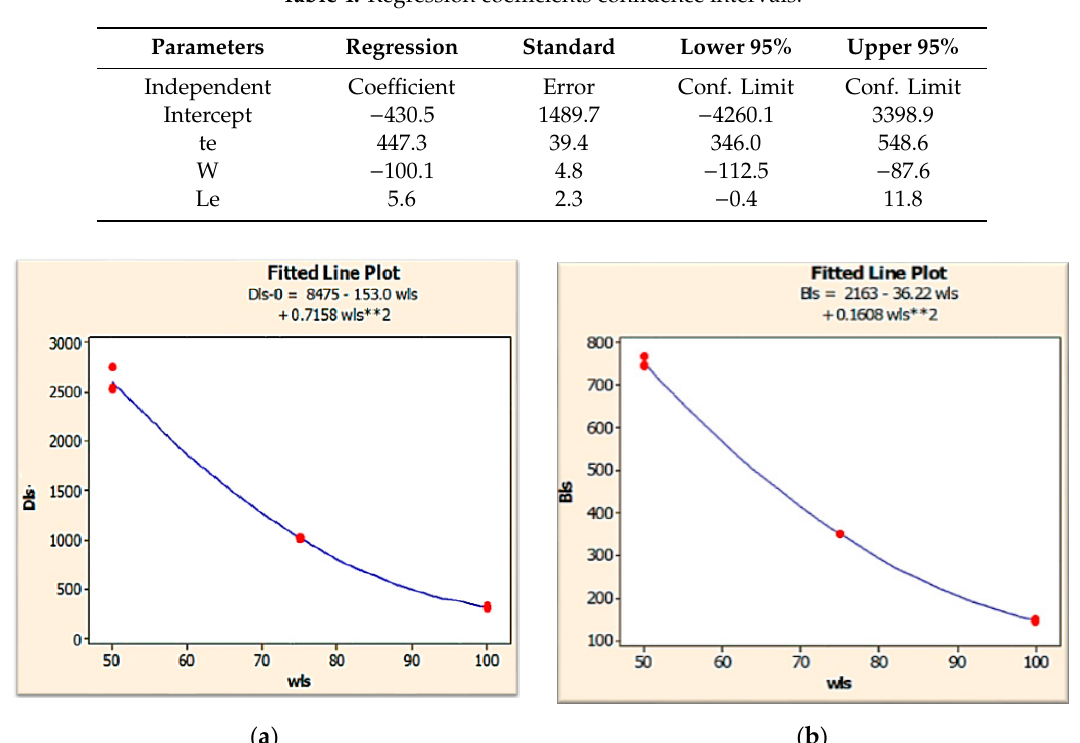
Figure 7. Variation of deflection and bending stress for different width.